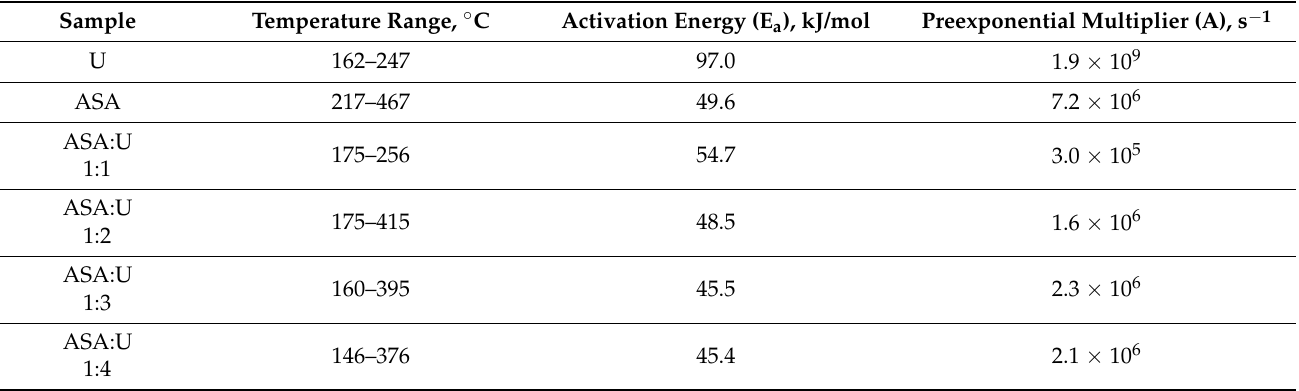
Table 1. Kinetic characteristics of thermal decomposition of